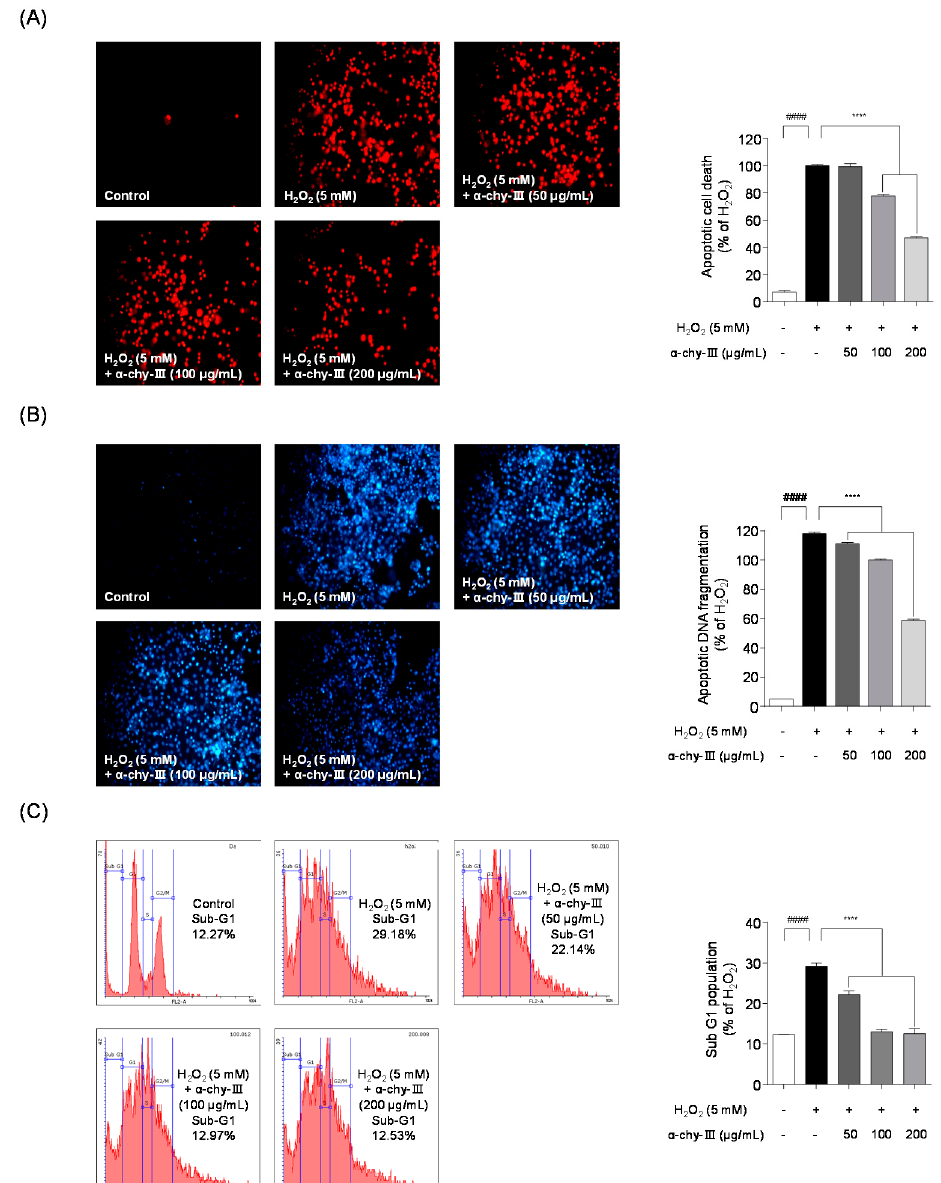
Figure 4. Effects of α -chy-III against H 2 O 2 induced apoptotic cell death, DNA fragmentation and cell cycle regulation in Vero cells. Protective effect of α -chy-III in H 2 O 2 induced apoptotic